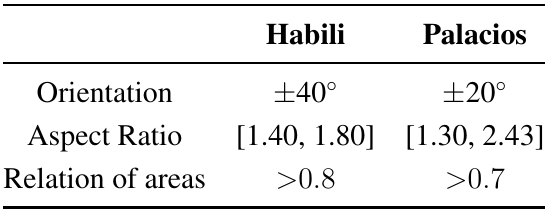
Table 2. Comparison of thresholds for face